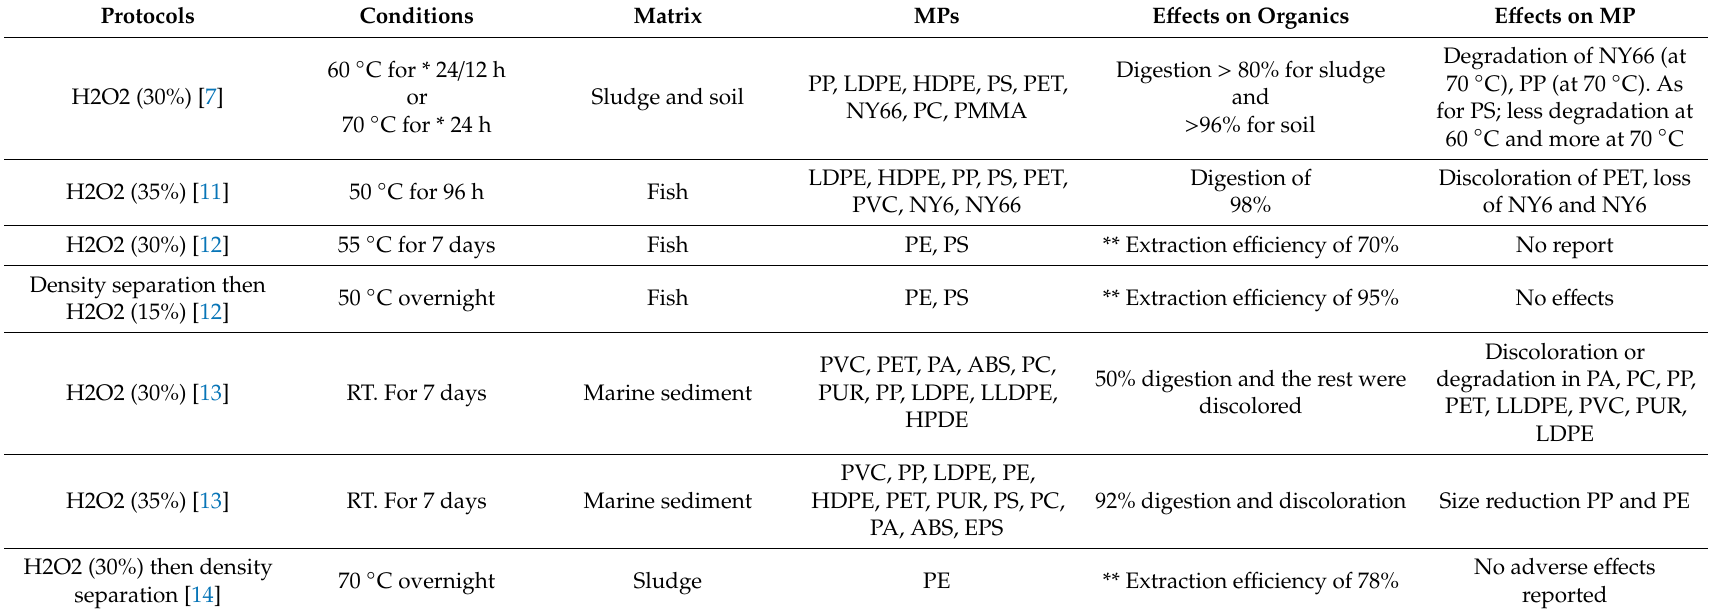
Table A1. Summary of various hydrogen peroxide protocols used in microplastic studies. RT—Room